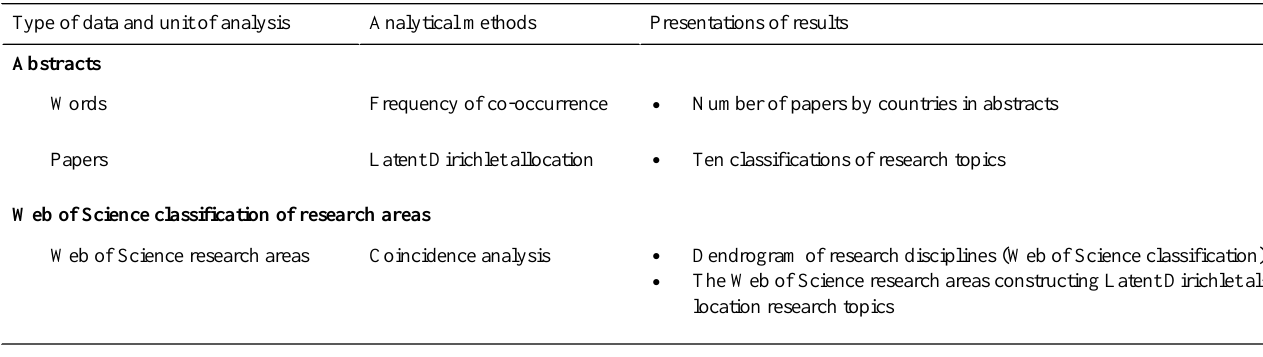
Table 1. Summary of analytical techniques for each data types.